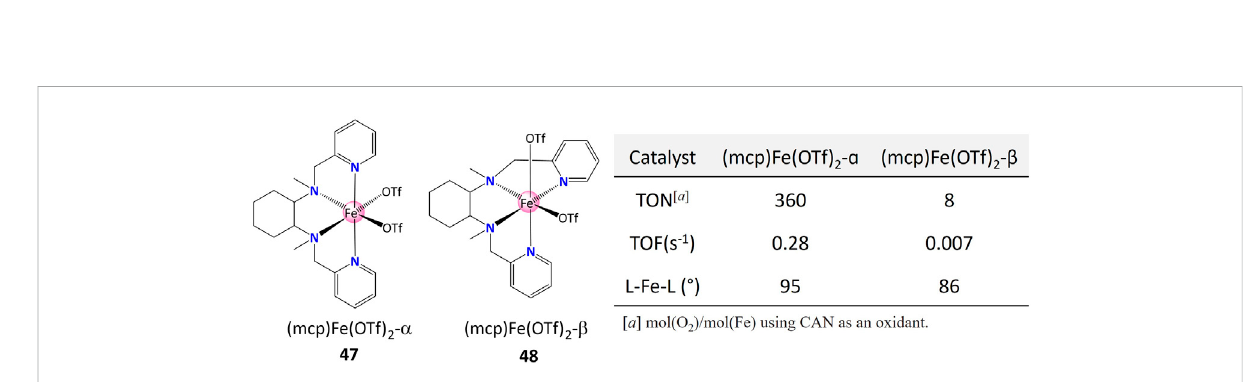
FIGURE 19 Comparison of catalytic and structural data for Fe WOCs 47 and 48. Data from ref (Panchbhai et al.,